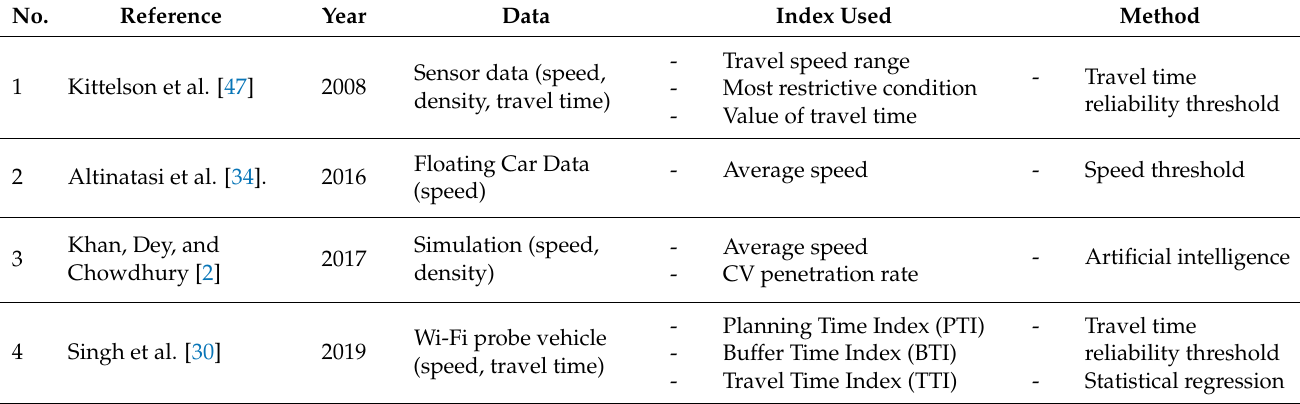
Table 1. Summary of alternative Level-of-Service (LOS) assessment methods in the